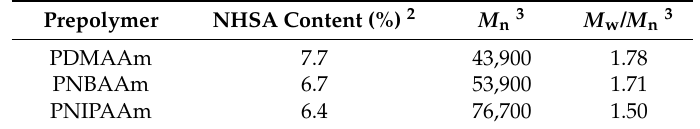
Table 1. Prepolymers for co-crosslinking gels prepared by radical copolymerization with NHSA. 1